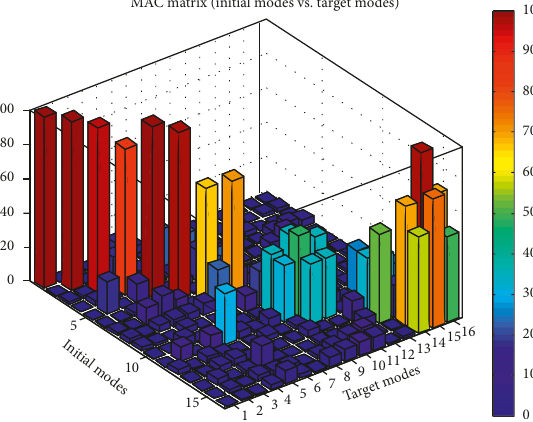
Figure 17: Mode shape for configuration 2 vs. configuration 4.